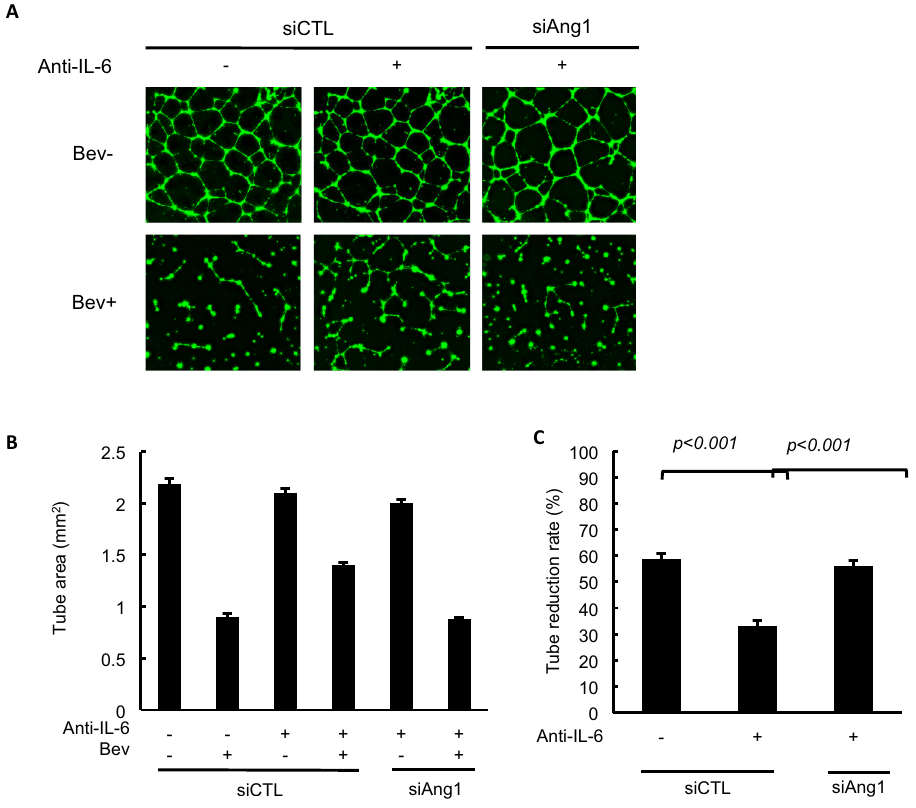
Figure 4. The role of Ang1 in IL-6 mediated Bev anti-angiogenic effect enhancement. ( A ) Images of tubes formed by HUVEC in the conditioned media from RMG-1 treated by indicated siRNA and anti-IL-6 antibody (magnification × 40). Fluorescent microscope observation was made after 18 h of incubation and Calcein AM staining. ( B ) Tubes in each well with indicated condition were measured by hybrid cell count software in order to elucidate the tube area. Data were average of triplicated well. (C) Reduction rate of tube area by Bev treatment with or without IL-6 blockade and siRNA, IL-6 blockade weakened Bev function in siCTL whereas siAng1 restored the anti-angiogenic function. Data are shown from one of two independent experiments with similar results. siCTL: siRNA without gene silencing ability (control). siAng1: angiopoietin-1 silencing siRNA. Error bars are SEs. All the images were observed by fluorescence microscope (BZ-X800, Keyence, Osaka, JAPAN). Then, these obtained images were analyzed by the BZ-H4C analytic application (Keyence) for hybrid cell count and the BZ-H4CM application (Keyence) for macro cell